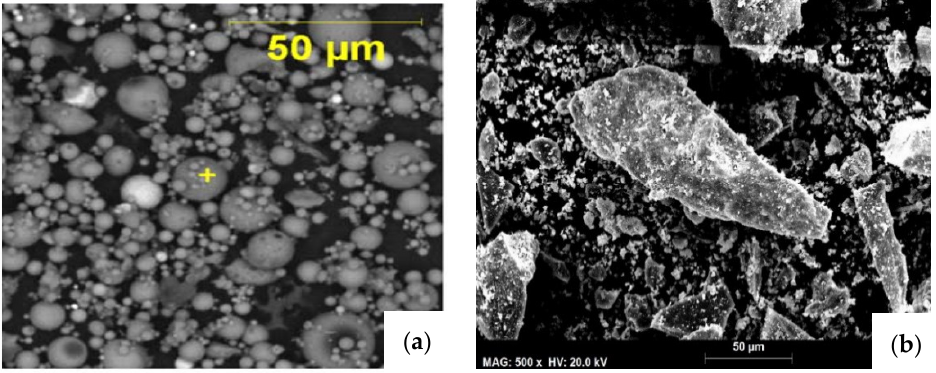
Figure 2. SEM images of ( a ) FA and ( b ) MIBA particles.